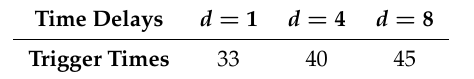
Table 1. The number of event triggers corresponding to different time